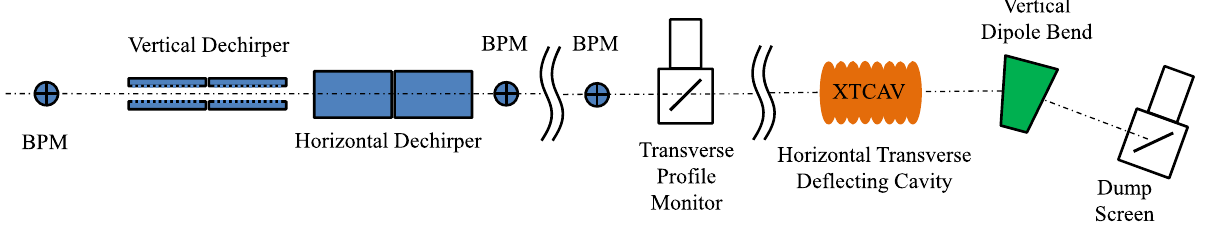
FIG. 8. Schematic of the proposed dechirper experiment (not to scale). See text for description.